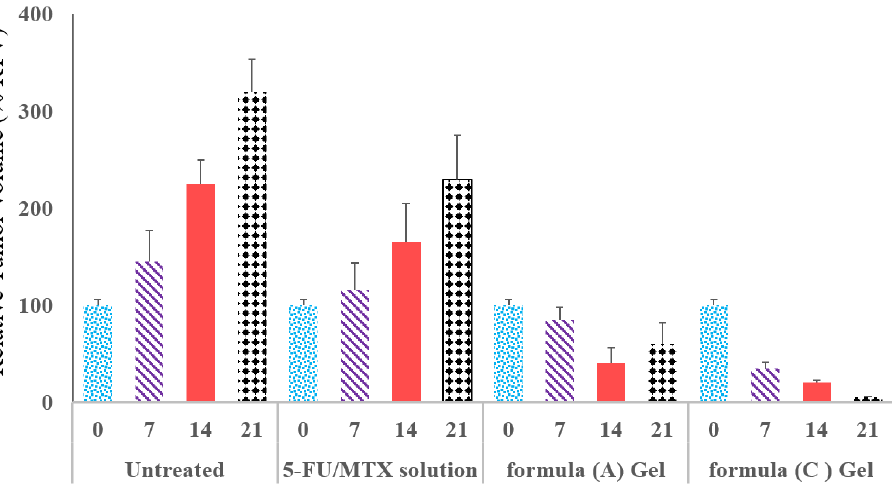
Figure 8. The percentage of relative tumor volume (%RTV) as an indication of antitumor efficacy of the modified hydrogel systems (formulas A and C) in comparison with the free drugs and untreated groups after their local injection into the breast tumor ( n = 8).